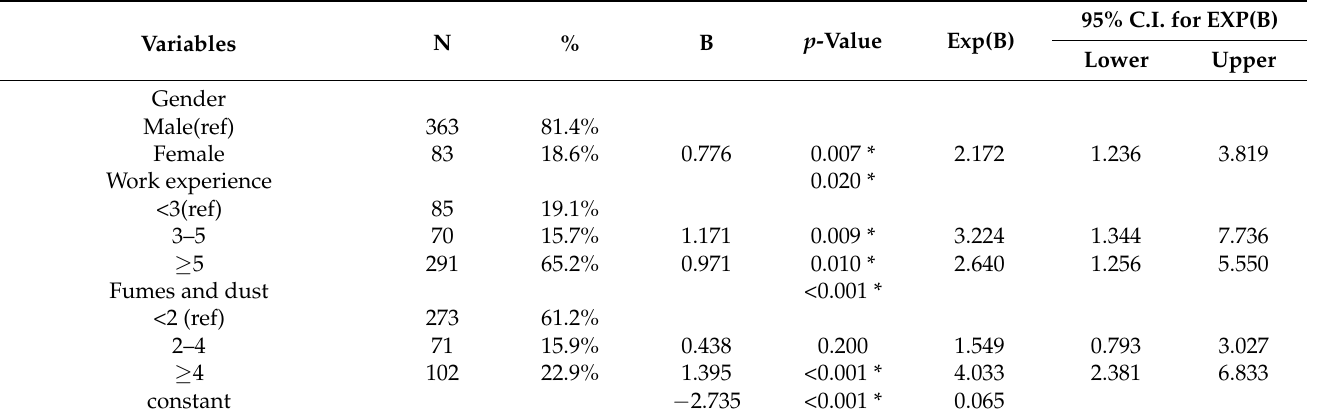
Table 13. Results of logistic regression on upper limb